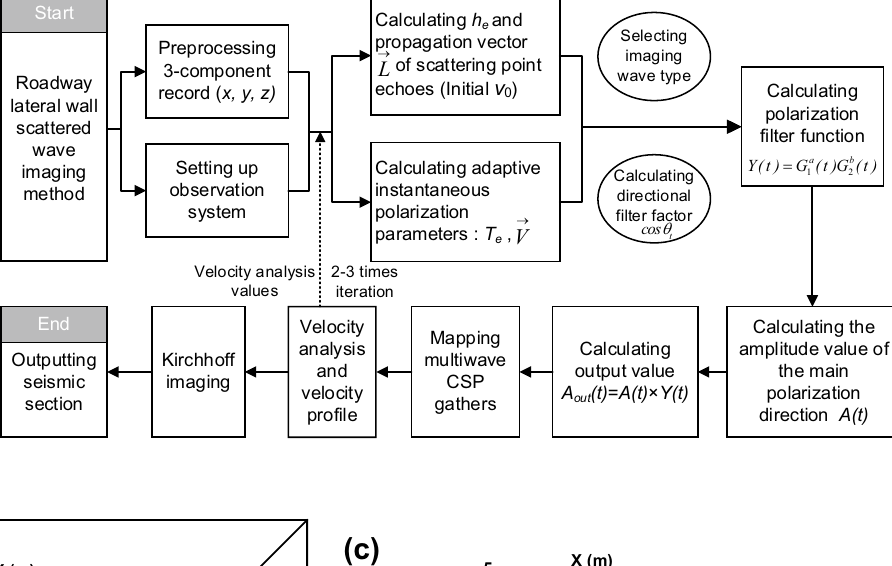
Fig. 3 Basic flowchart for the